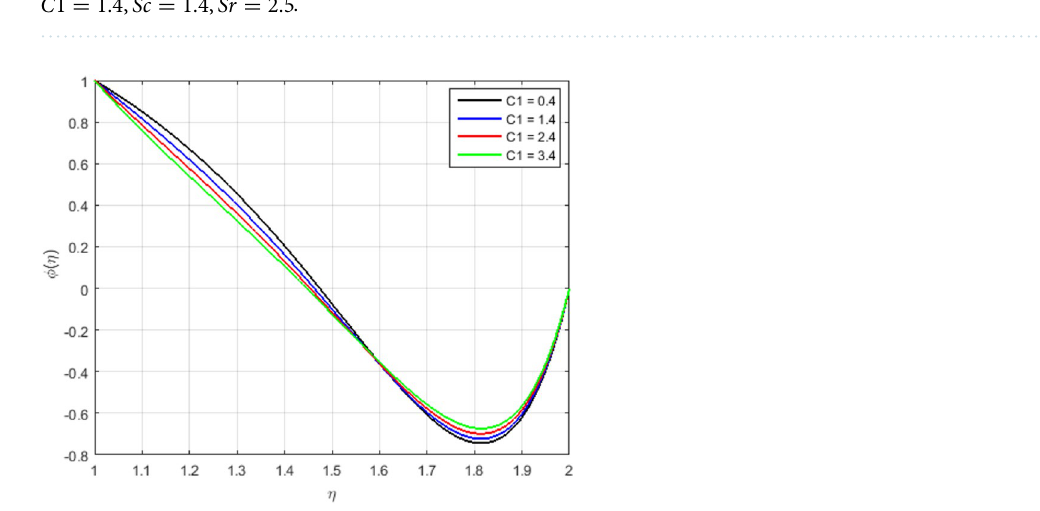
Figure 10. Influence of θ(η) and φ(η) for Hs and fixed values of S = 2.5, M = 1.4, Pr = 2.2, Re m = 2.5, C 1 = 1.4, Sc = 1.4, Sr = 2.5 .